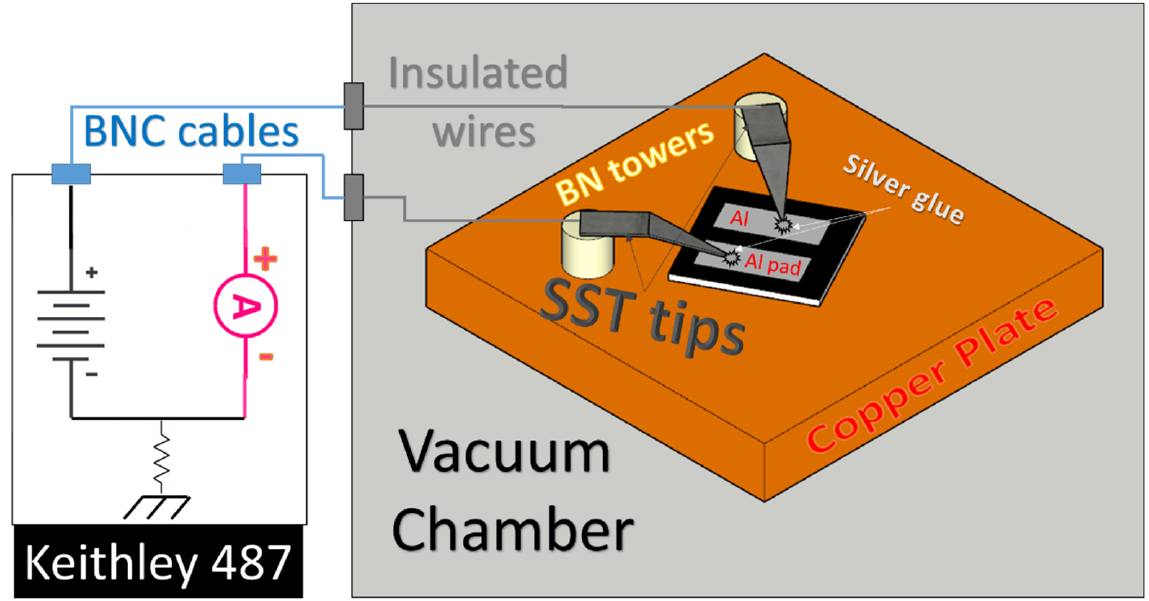
Figure 3. Sketch of the current measurements experimental setup.